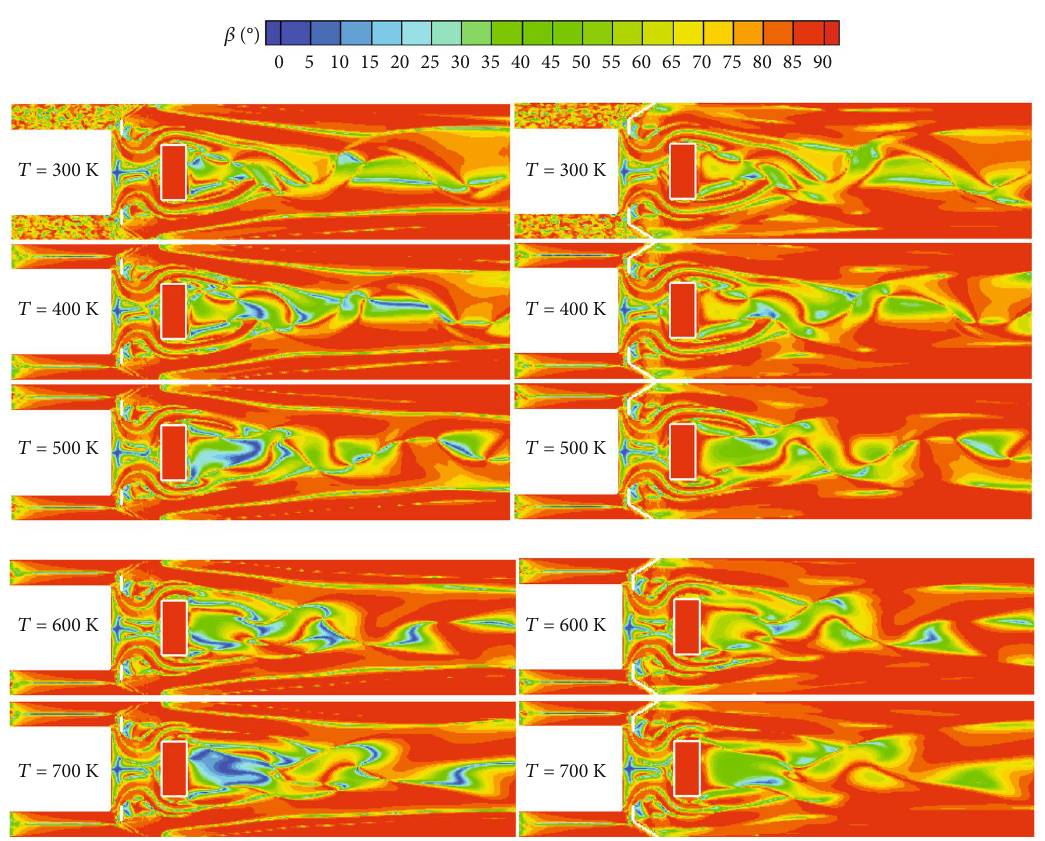
Figure 31: Synergy angle distribution under di ff erent inlet temperatures.